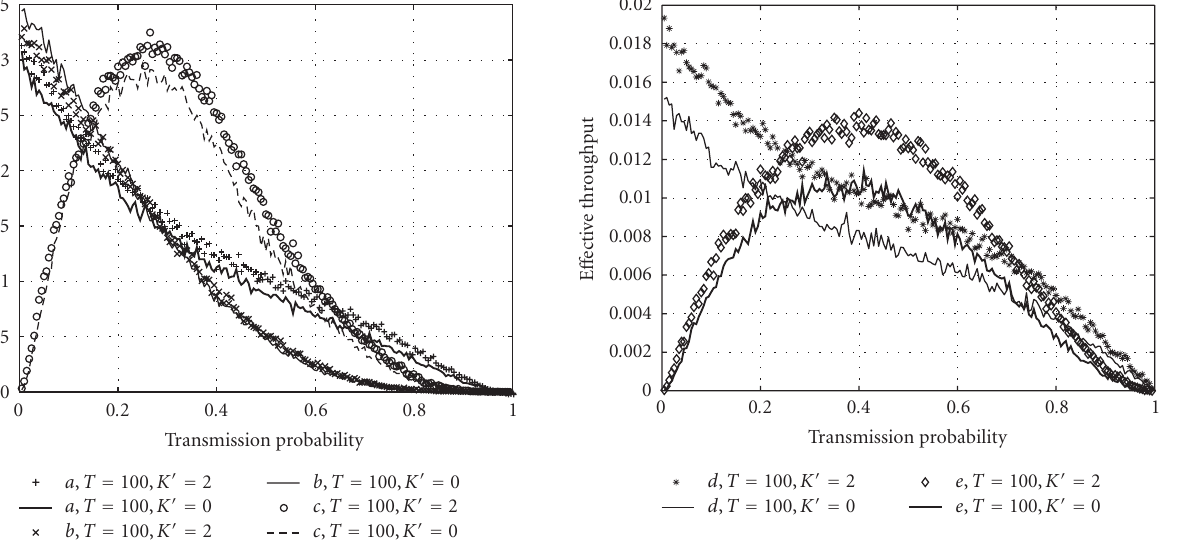
Figure 27: The e ff ective throughput of the dynamic ( K (cid:5) = 2) and the static ( K (cid:5) = 0) cases for K = 4 and T = 100 (connections a , b , and c of the asymmetric network of Figure 11).